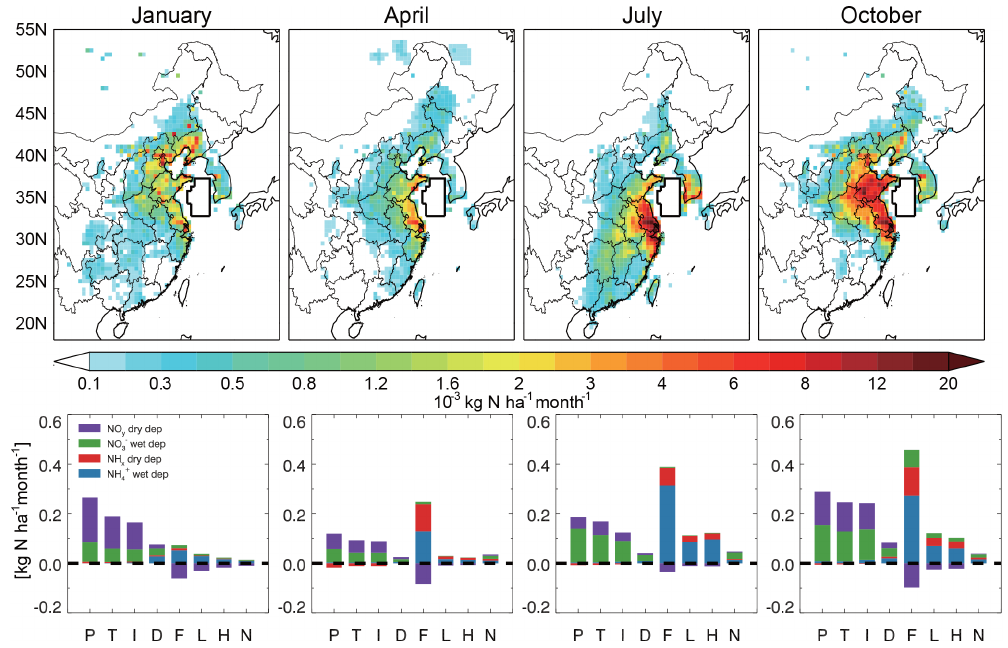
Figure 11. (Top panels) sensitivity of monthly total nitrogen deposition over the Yellow Sea to emissions in each grid box, and (bottom panels) sensitivity of nitrogen deposition over the Yellow sea (domain defined by the black lines) to each emission sector. In the x axis, label